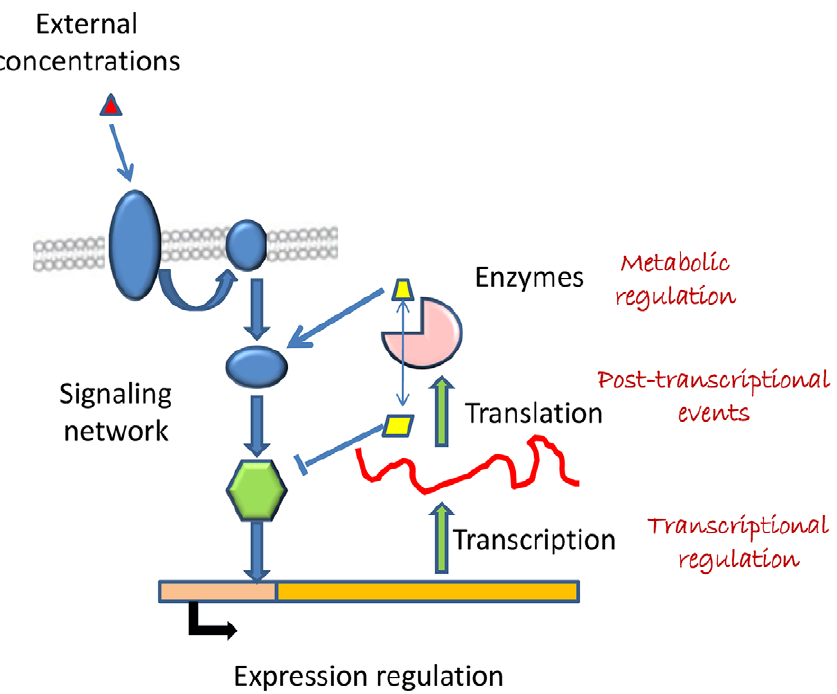
Figure 1. Illustration of the regulatory mechanisms of cellular metabolism. The fluxes can be regulated at the level of mRNA transcription, by the concentrations of the metabolites or by intermediate steps such as translation or activation of the enzymes.